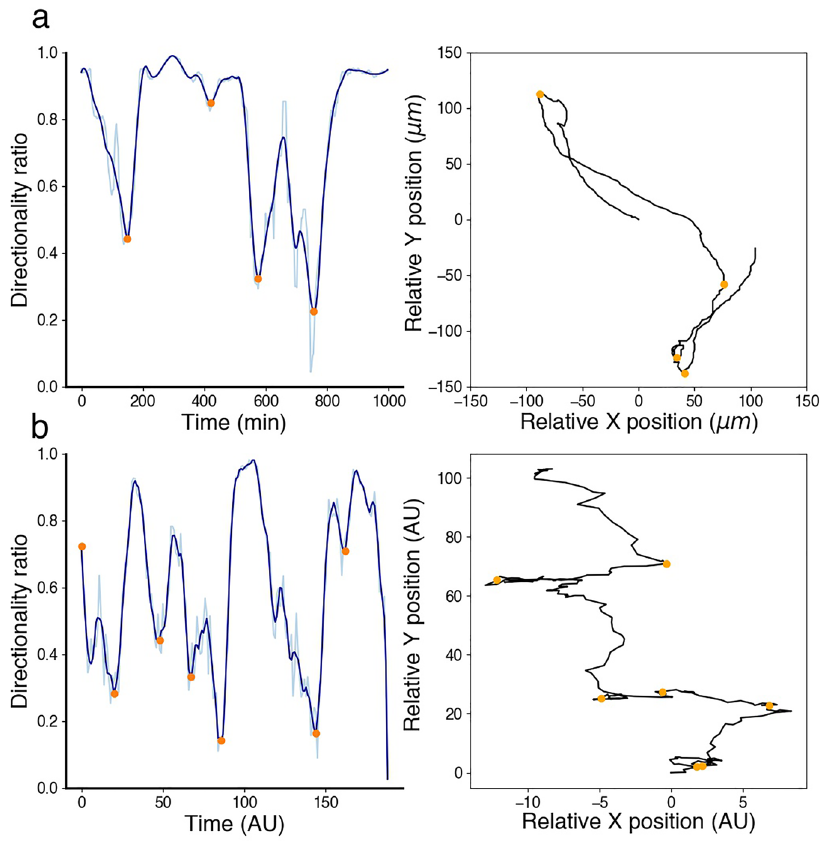
Figure 5. Periods of directedness and directionality change in active CHO-K1 and oscillating CPM cells. Event detection framework applied to ( a ) an active CHO-K1 cell, and ( b ) an oscillating CPM cell. Directionality ratio (left panels), computed using a rolling window of length 60 min (light blue) for an active CHO-K1 cell and 20 time-steps for an oscillating CPM cells, allowed for event detection (orange dots). Superimposing detected events (orange dots) on cell tracks (right panel) shows a good agreement with directionality